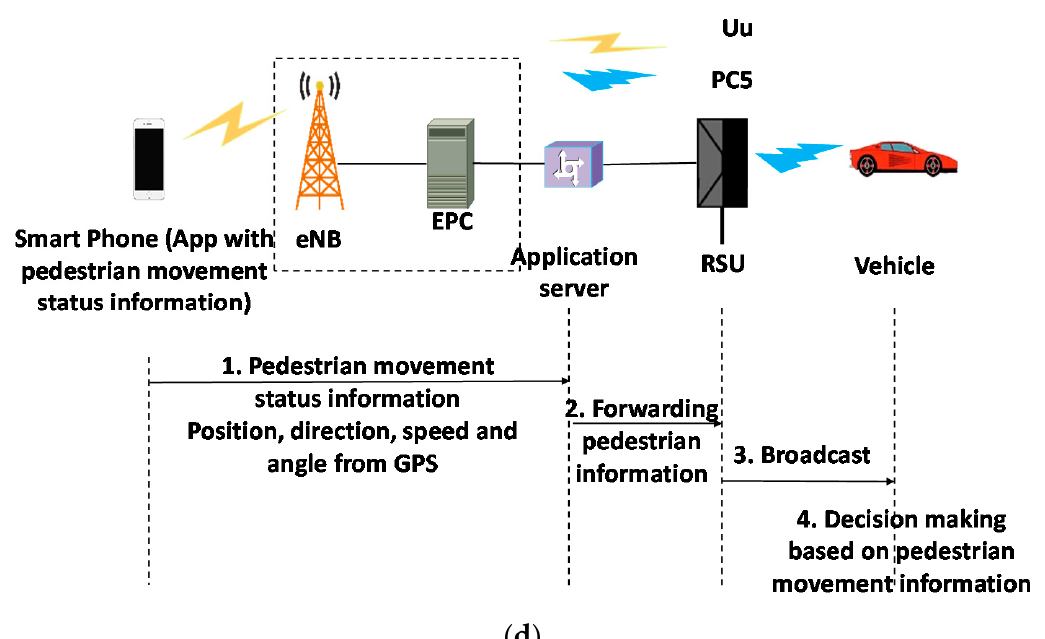
Figure 13. Vehicle-pedestrian anti-collision . ( a ). Photo of movement status information from the smart terminal; ( b ). Photo of eNB in the test; ( c ). Photo of RSU in the test; ( d ). Communication process of vehicle-pedestrian anti-collision.